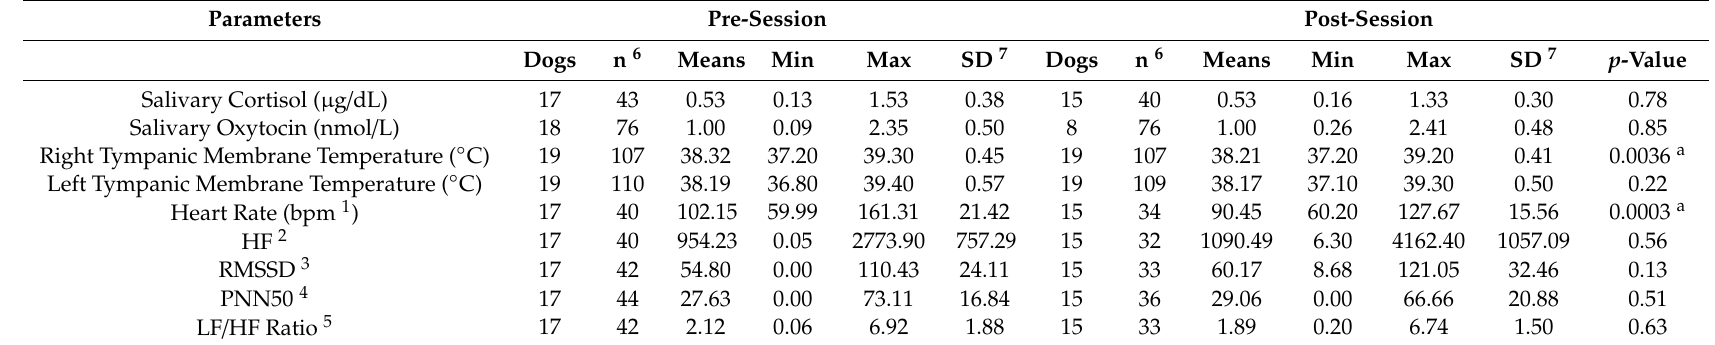
Table 3. Physiological parameters of therapy dogs pre- and post-20-min interaction with a fibromyalgia patient.